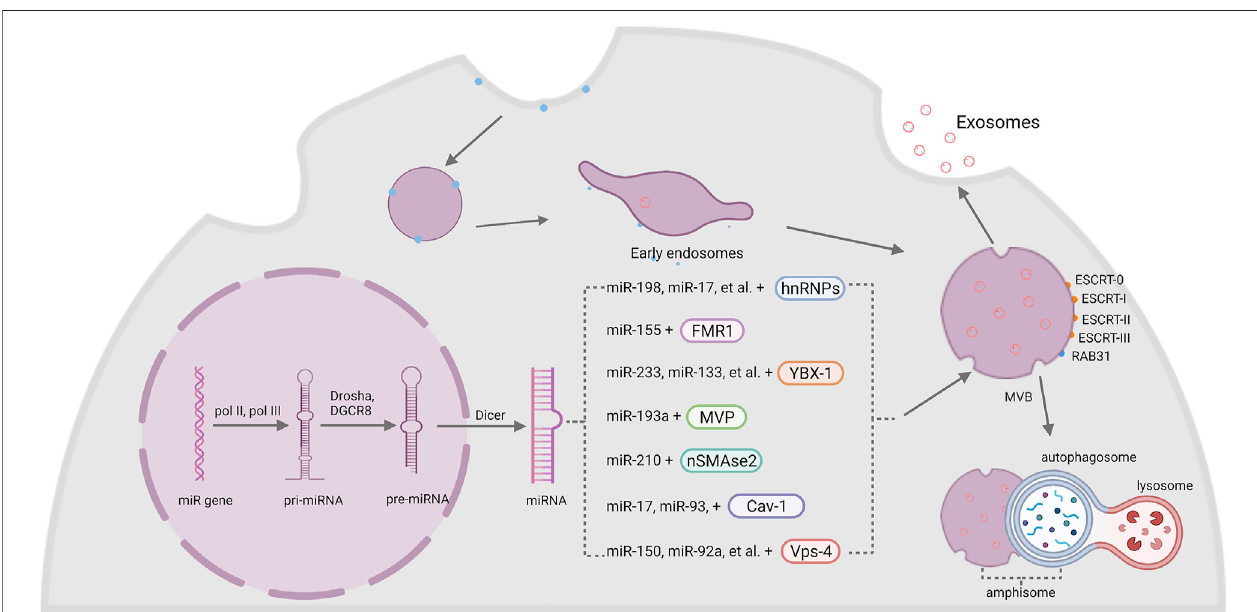
FIGURE 1 | The biogenesis of exosomal miRNA. The intramembranous budding of plasma membrane forms exosomes with the help of RAB31 or endosomal sorting complexes required for transport (ESCRT-0, -I, -II, -III). MiRNA genes are transcribed into pri-miRNA by pol II and pol III, then Drosha and DGCR8 modify it into pre-miRNA and generate a mature miRNA with the help of Dicer. Finally, miRNAs are sorted into exosomes by two kinds of membrane: RBPs and membrane proteins, including hnRNPs, FMR1, YBX-1, MVP, nSMase2, Cav-1 and Vps-4.